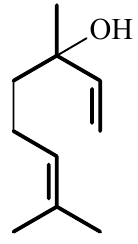
C isoprene unit 5